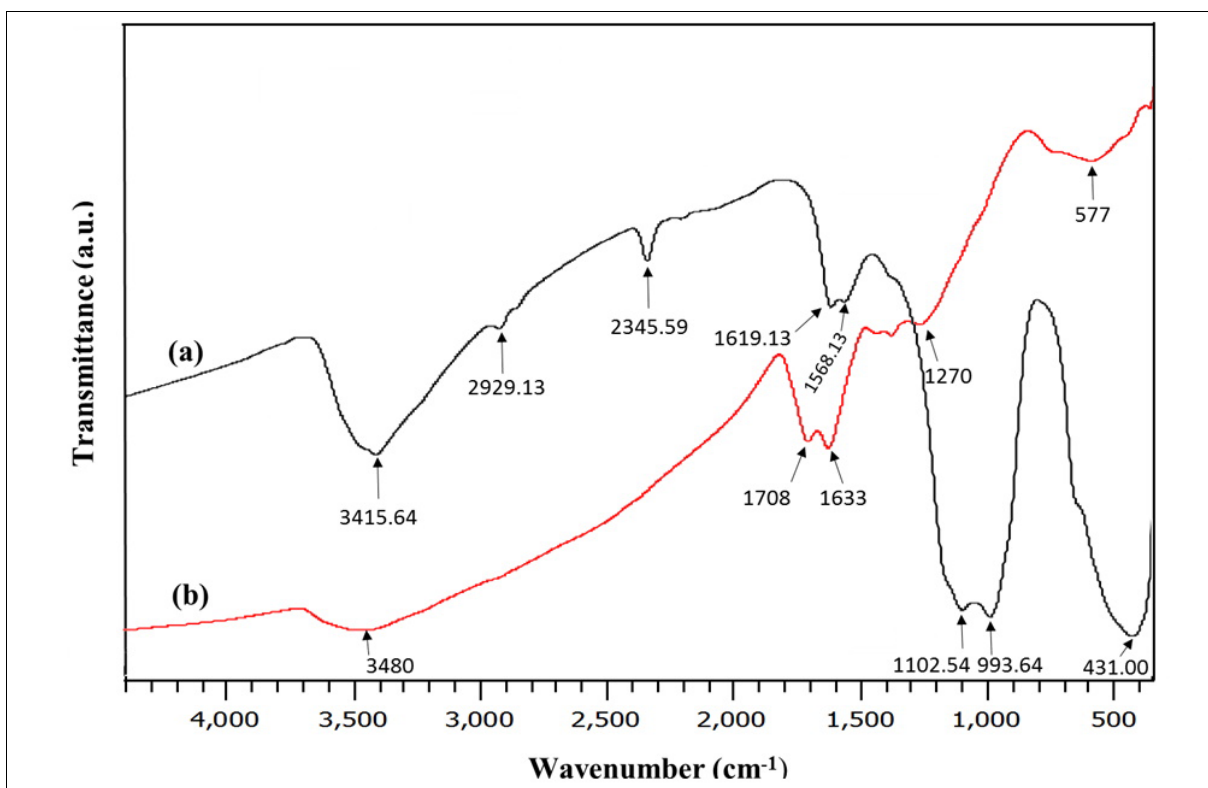
Figure 6: Fourier transform infrared spectra showing the vibrational modes of the bonds present in (a) ZnO_CNPs and (b)